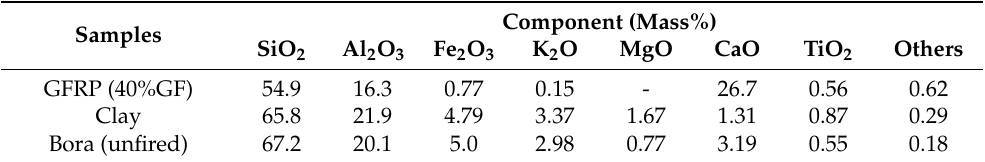
Table 1. The compositions of inorganic substances in the glass fiber-reinforced plastic (GFRP), clay, and